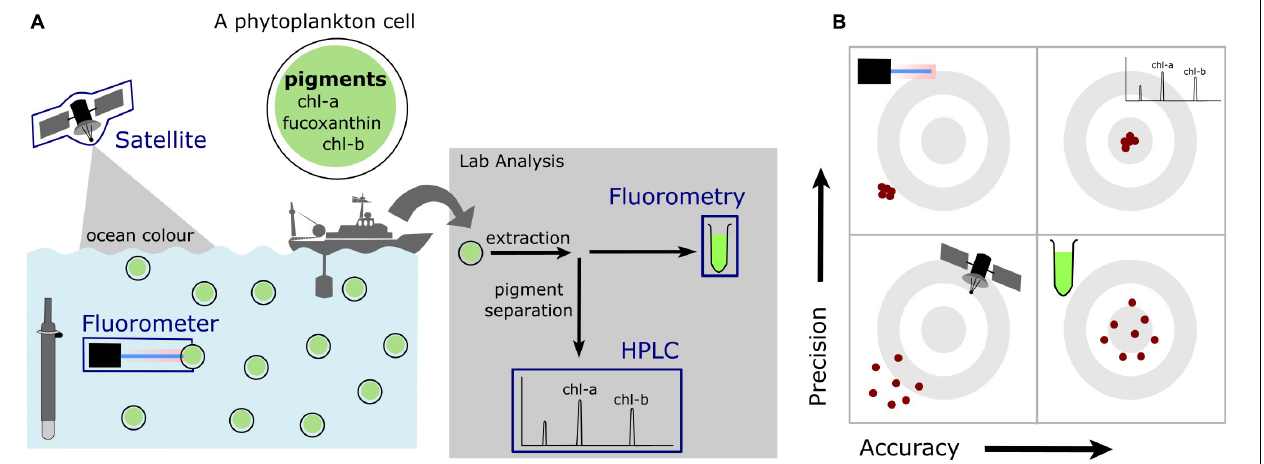
FIGURE 3 | A schematic of (A) the different methods of measuring chlorophyll- a in the ocean discussed within this review and (B) a representation of differences in precision and accuracy for these methods. The gray concentric circles illustrate targets, where the center is indicative of an accurate and precise measurement, with the red dots illustrating the differences between accuracy and precision. Four targets are presented to illustrate varying degrees of precision and